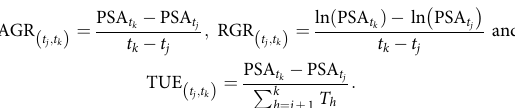
were displayed in Manhattan plots (Supplementary Fig. 5), using the qqman package for R 55 .